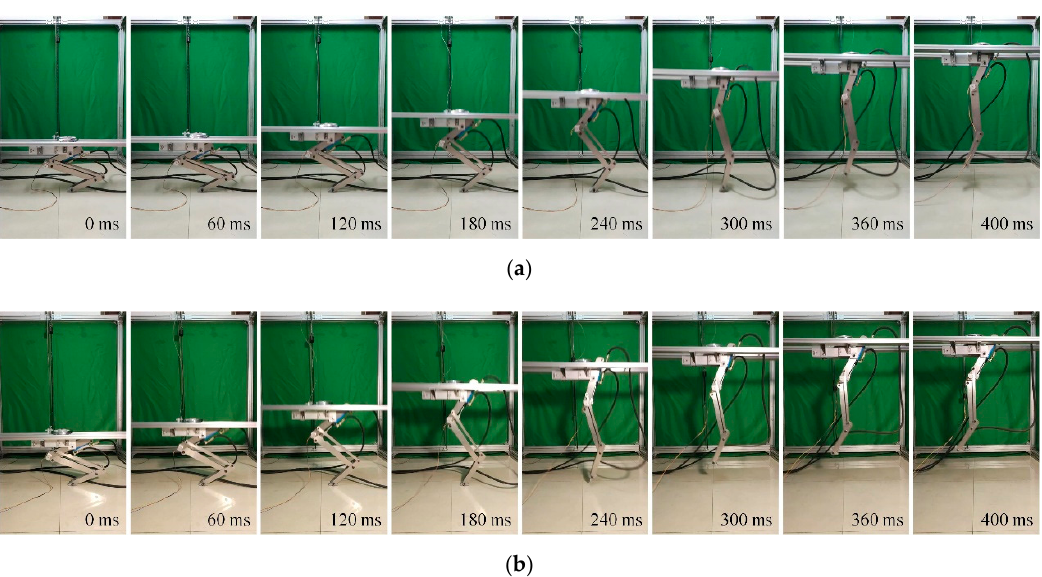
Figure 6. Images of hopping locomotion under the two attachment geometries recorded at 100 fps. ( a ) Hopping locomotion under the DAG; ( b ) Hopping locomotion under the FMAG.